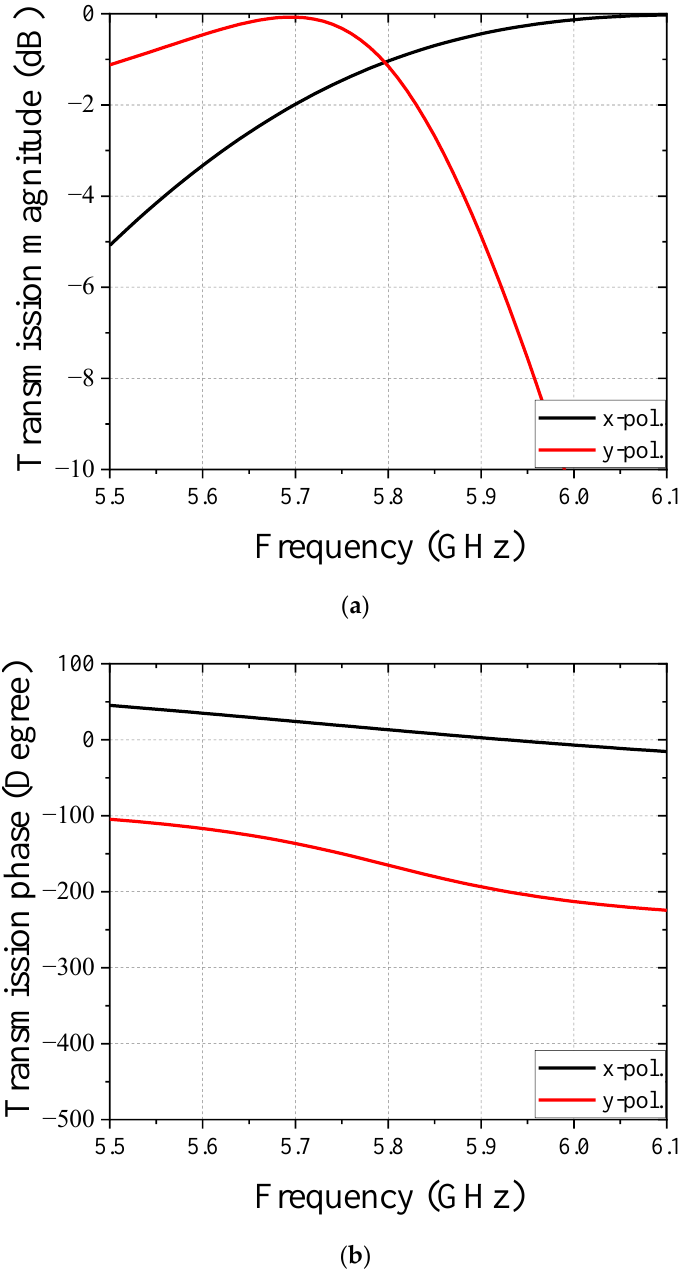
Figure 2. Full-wave simulated transmission responses of the unit cell of anisotropic surface. ( a ) Mag- nitude ( b ) Phase. ( a ) Magnitude ( b )